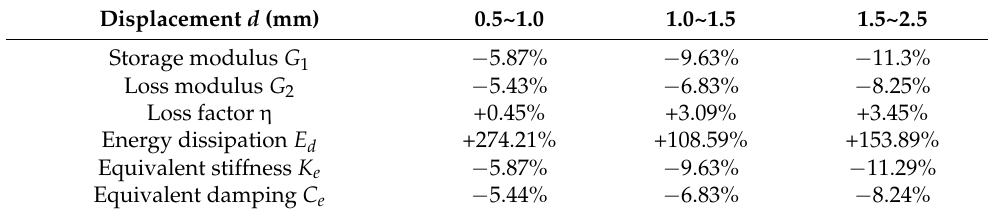
Table 5. Parameters’ changing rate with varying displacement amplitudes when f = 5.0 Hz.